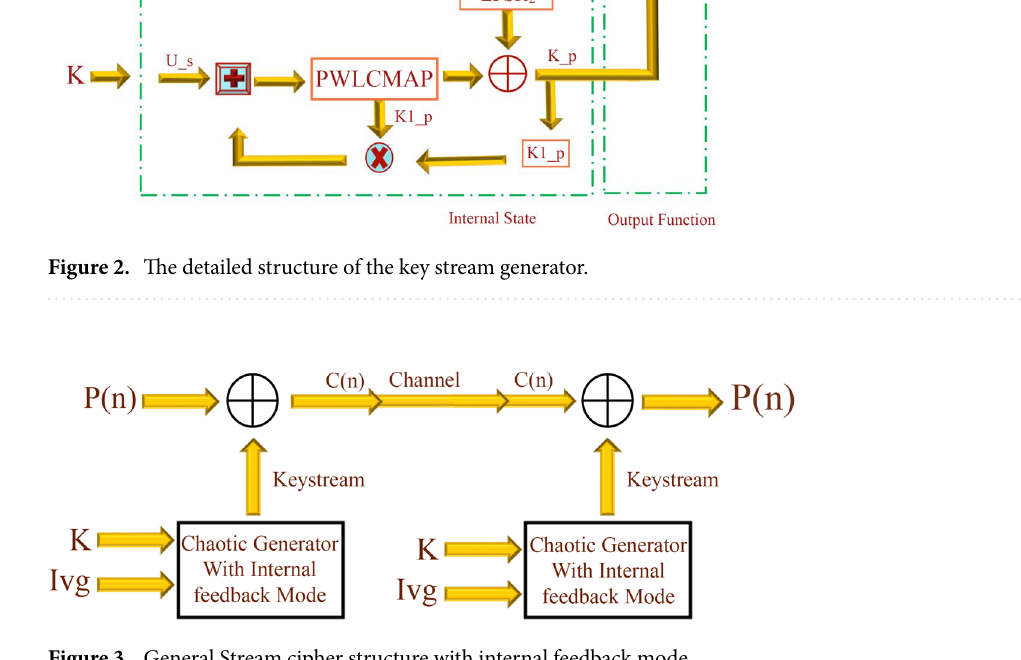
Figure 3. General Stream cipher structure with internal feedback